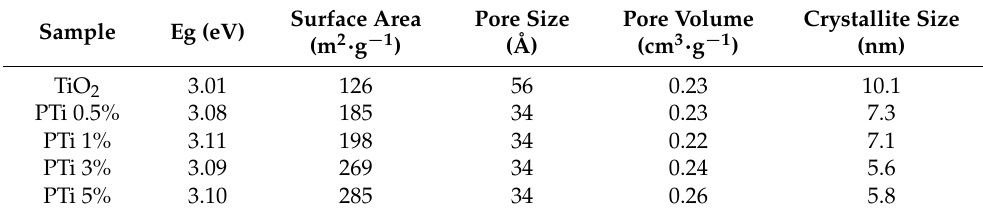
Table 1. Structural parameters of mesoporous TiO 2 calcined at 400 ◦ C. Reproduced from reference [20] with permission of Wiley Online